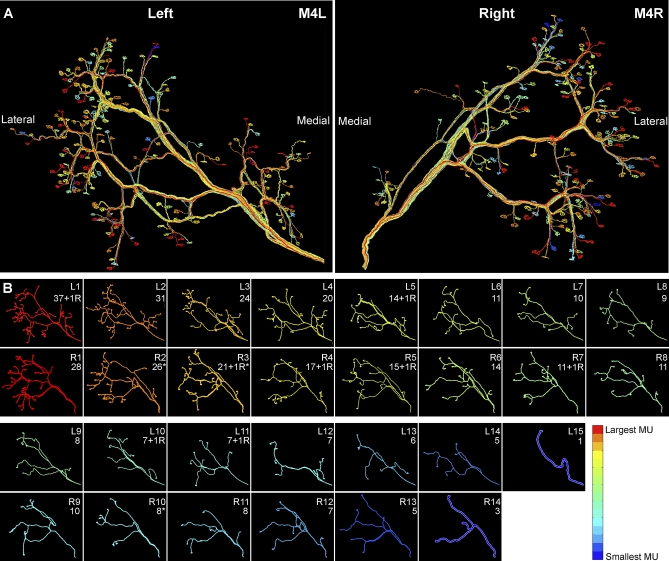
Connectomes of a Left-Right Pair of Interscutularis Muscles(A) Axons in the connectomes of the left (L) and right (R) interscutularis muscles of a 1-mo-old animal (M4) were color-coded based on the rank-order of their motor unit sizes in each connectome.(B) Comparison of the branching pattern of each axon with its contralateral counterpart from the largest (L1 and R1) to the smallest (L15, R14). Axons in M4R were flipped horizontally to facilitate visual comparison. Lower numbers in each panel indicate motor unit sizes. R, retraction bulb; *, one NMJ co-innervated by two axons.